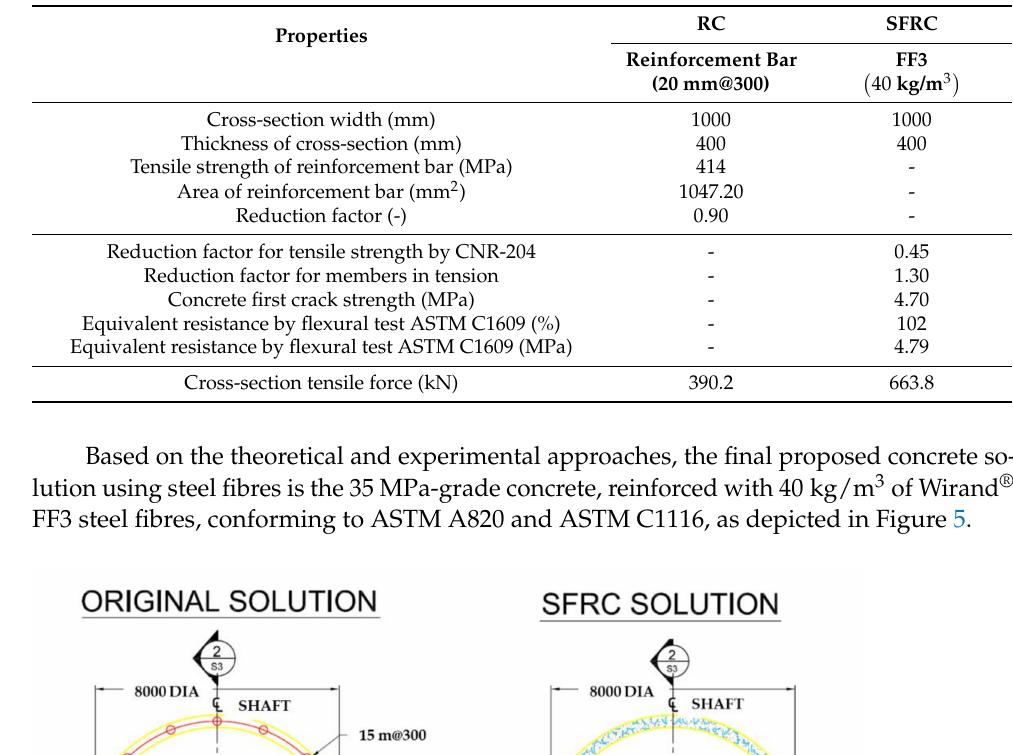
Table 3. Comparison of tension resistance of conventional RC and SFRC.